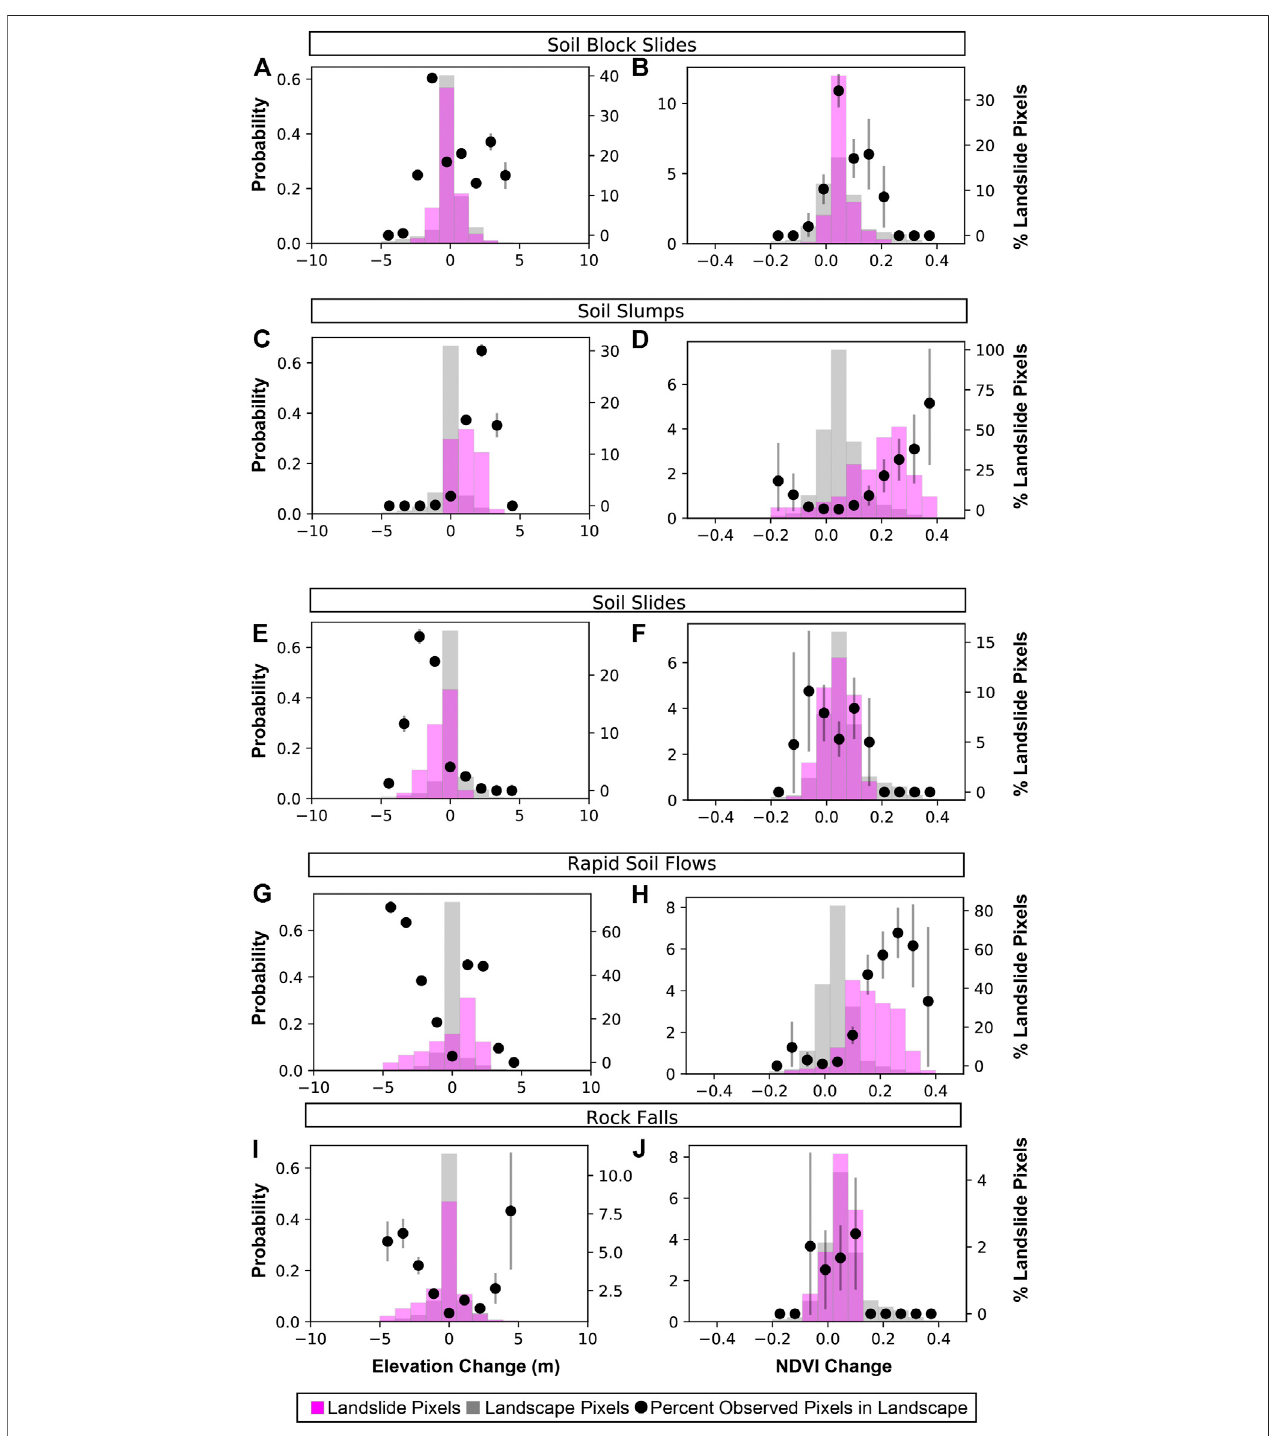
FIGURE 5 | Probability distributions comparing landslide pixels to landscape pixels by landslide type for the elevation and NDVI differencing methods. Panels (A) and (B) display the distributions that correspond to soil block slides for the elevation and NDVI differencing methods, respectively. Similarly, panels (C) and (D) correspond to soil slumps, panels (E) and (F) correspond to soil slides, (G) and (H) correspond to rapid soil fl ows and (I) and (J) correspond to rock falls. Con fi dence interval for each point shown as gray line (signi fi cance level 0.05).